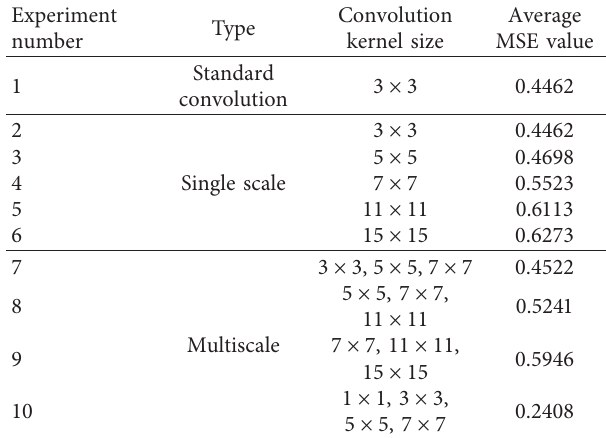
Table 3: MSE numerical evaluation of multiscale features on re- construction